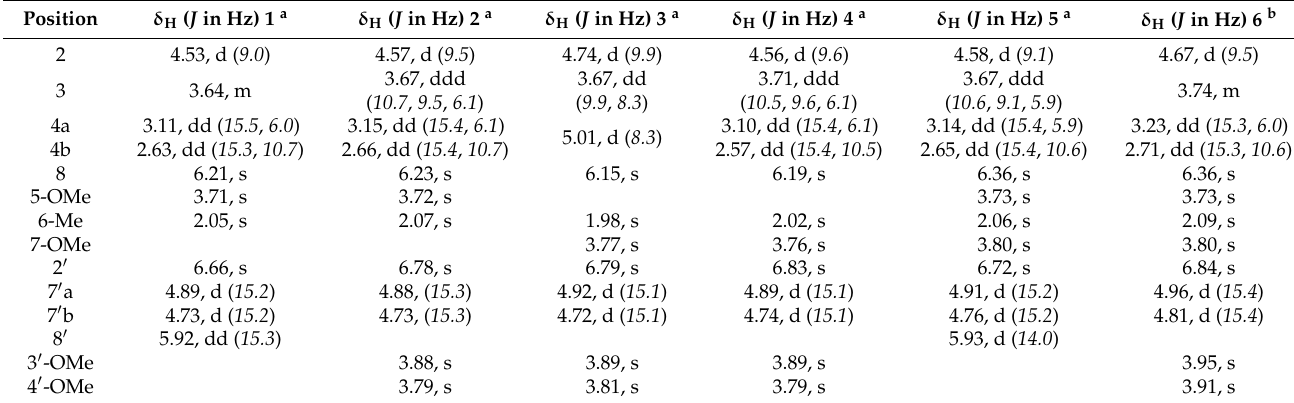
Table 1. 1 H NMR data for compounds 1 – 6 .